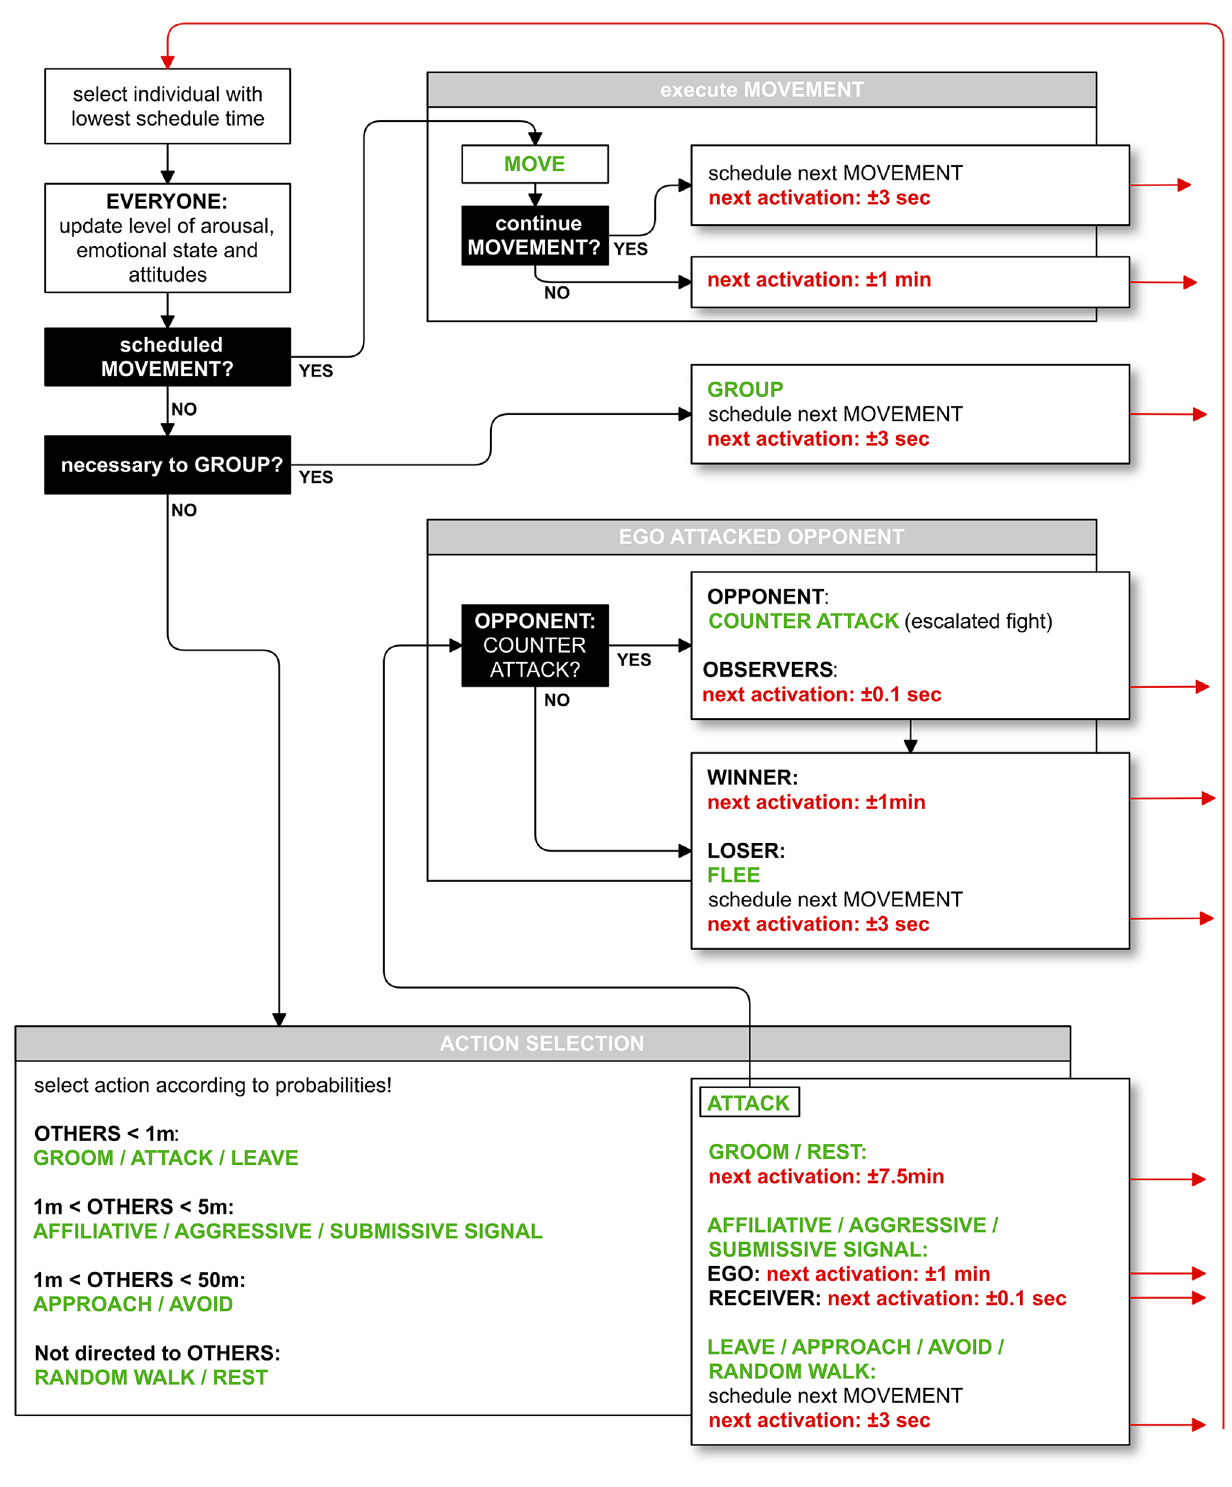
Figure 1. Process overview of the model. This figure illustrates the order of the processes executed by the model entities and their timing